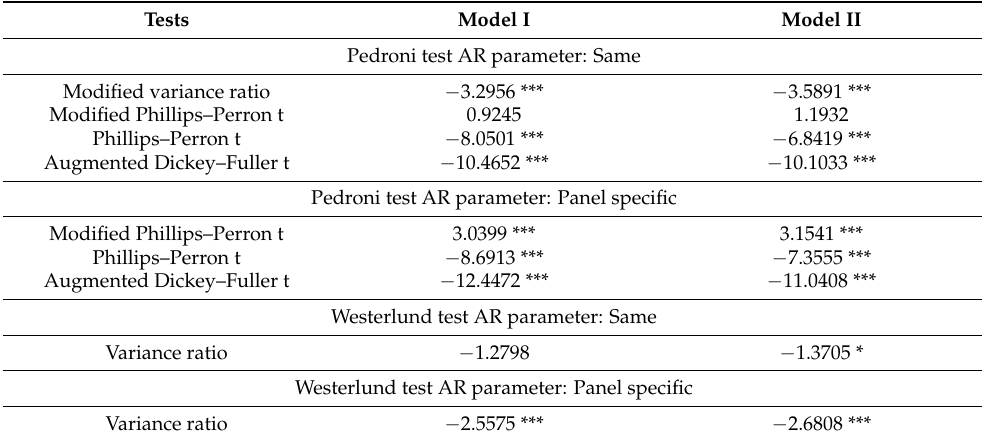
Table 6. Pedroni and Westerlund panel cointegration tests results.